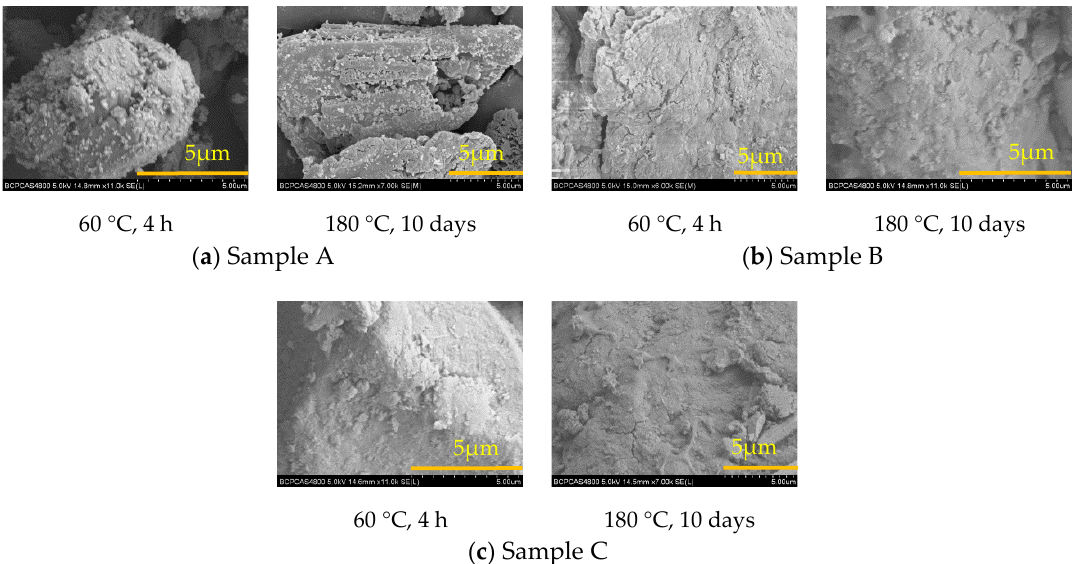
Figure 2. The SEM images of three kinds of Mg/TeO 2 ignition composition before and after the high-temperature test.